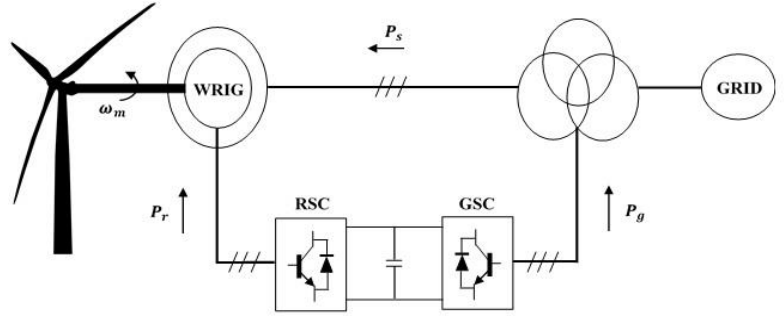
Figure 1. Overall doubly fed induction generator (DFIG)-based wind turbine.